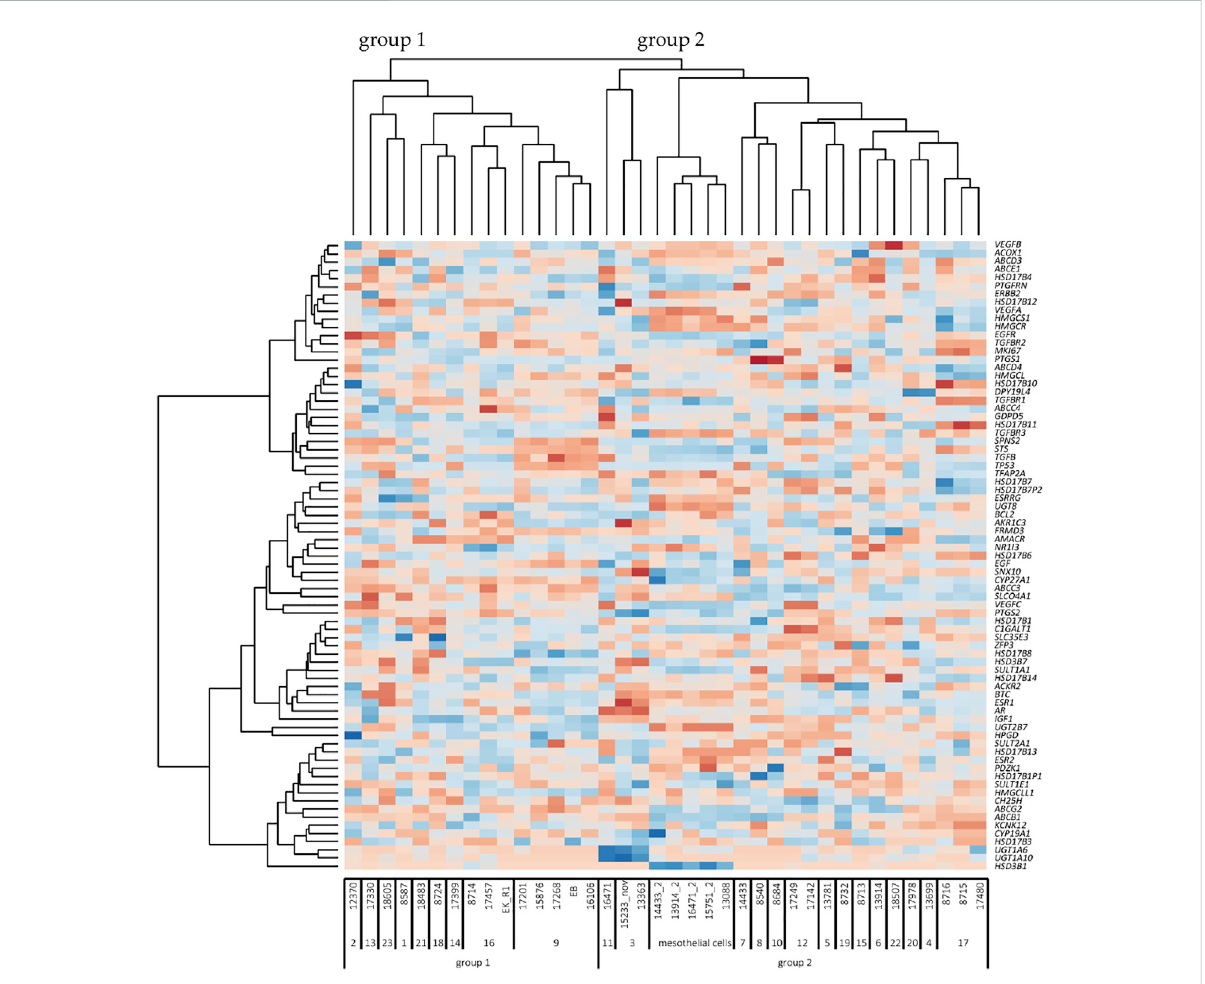
FIGURE 4 Heatmap of unsupervised clustering analysis ( n = 38 cell lines). Cell names are indicated below the heatmap. The numbers under the cell line names represent the code used for each patient. Group 1 and 2 indicates the two large cell clusters according to the pattern of genes (dark red, minimumlog2expression;darkblue,maximumlog2expression).Ontheright-handside,the77genesareindicated.The5mesothelialcelllineshave low levels of SLCO4A1, but the overall pattern of genes is related to group 2 of ovarian cancer cells. Note that various column clusters are built from cell lines obtained from the same